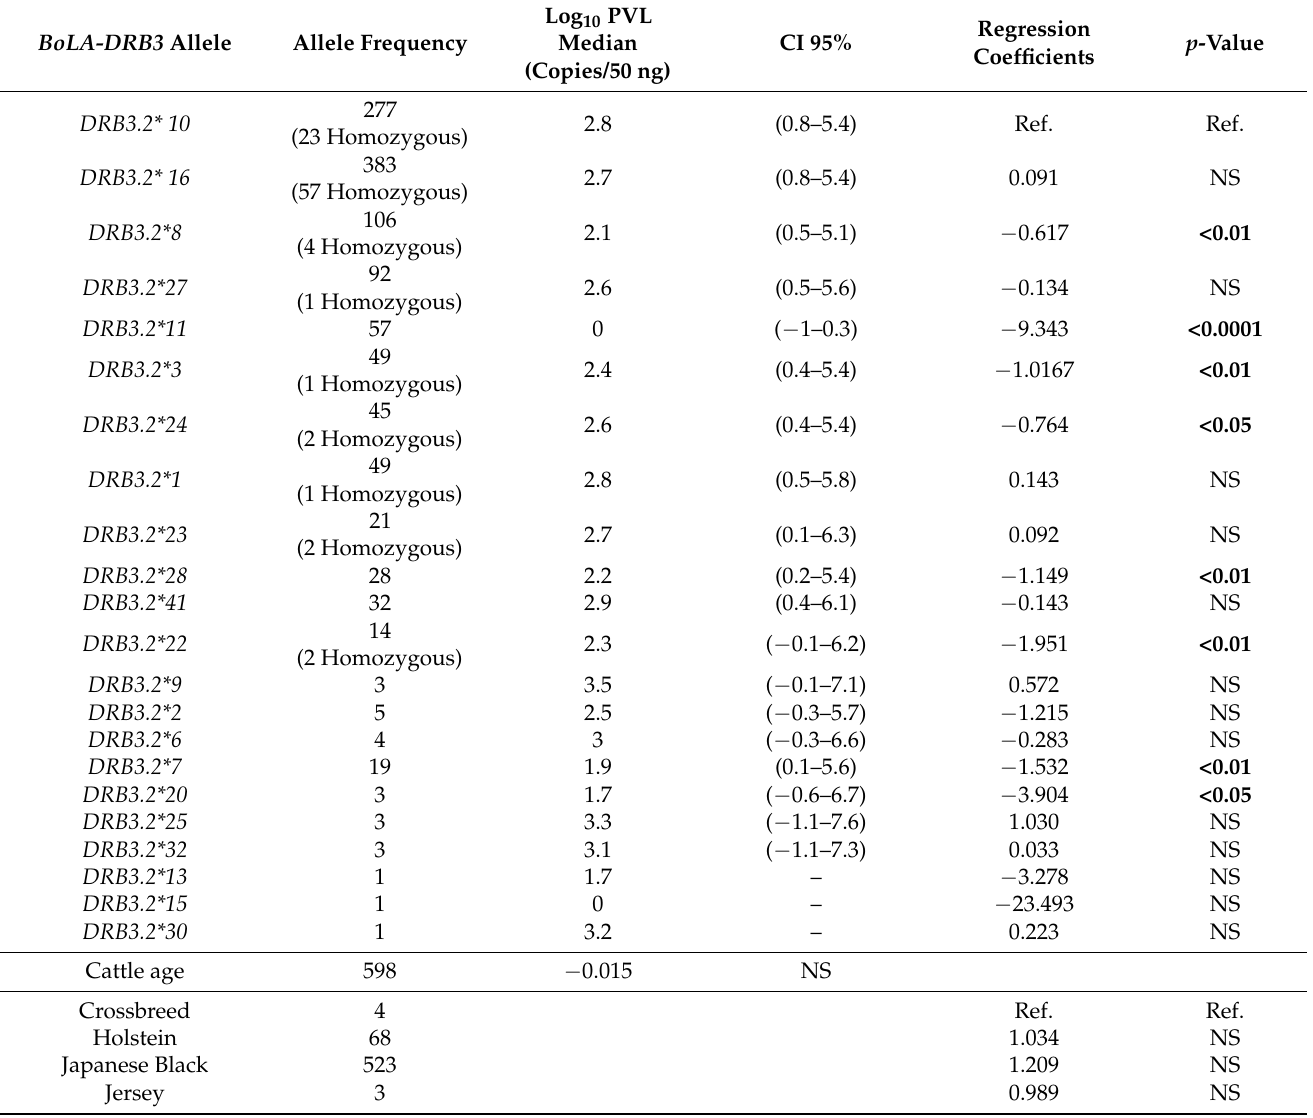
Table 3. BoLA-DRB3 allele frequencies, univariate negative binomial regression of BLV PVLs and BoLA-DRB3 alleles, and age and breed of the cattle